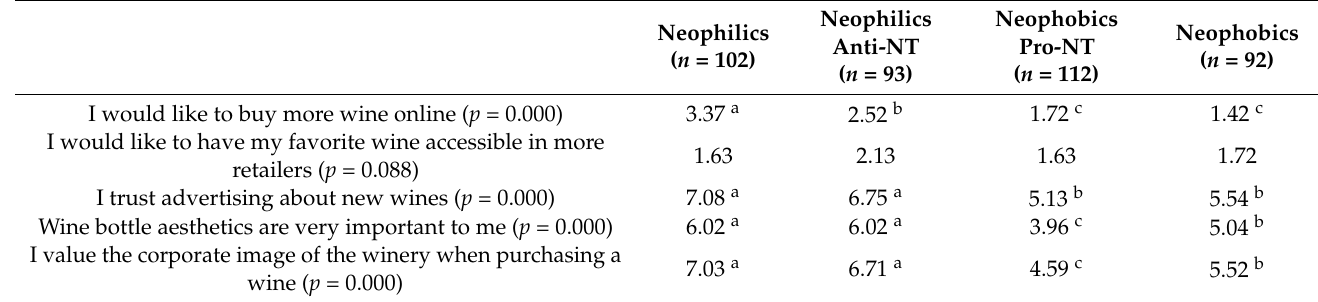
Table 4. Impacts of WN and FTN on wine consumers’ opinions toward statements linked to wine innovation.